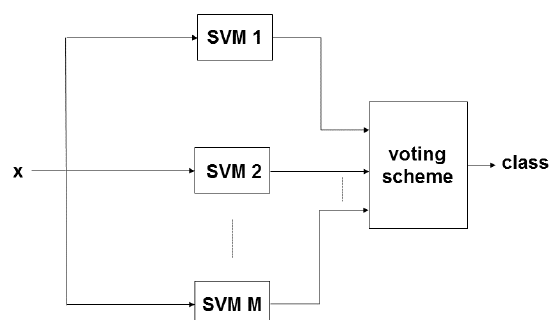
Figure 3. Solving multi-class problems with binary SVMs (x=feature vector, class=classification result). Modified after (Melgani and Bruzzone, 2004).